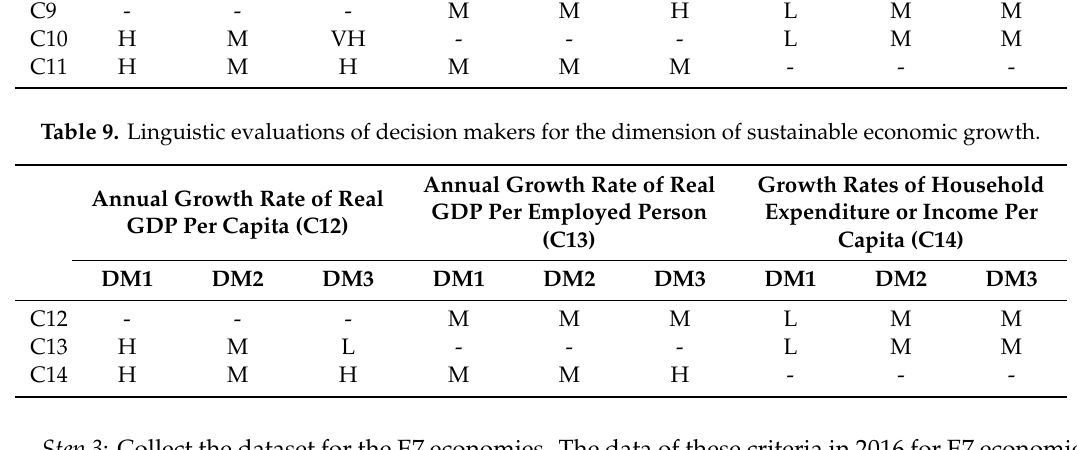
Table 8. Linguistic evaluations of decision makers for the dimension of catastrophic health spending. Poverty Gap due to out of Pushed below an Catastrophic out of Pocket International Poverty Line Health Spending (C9)